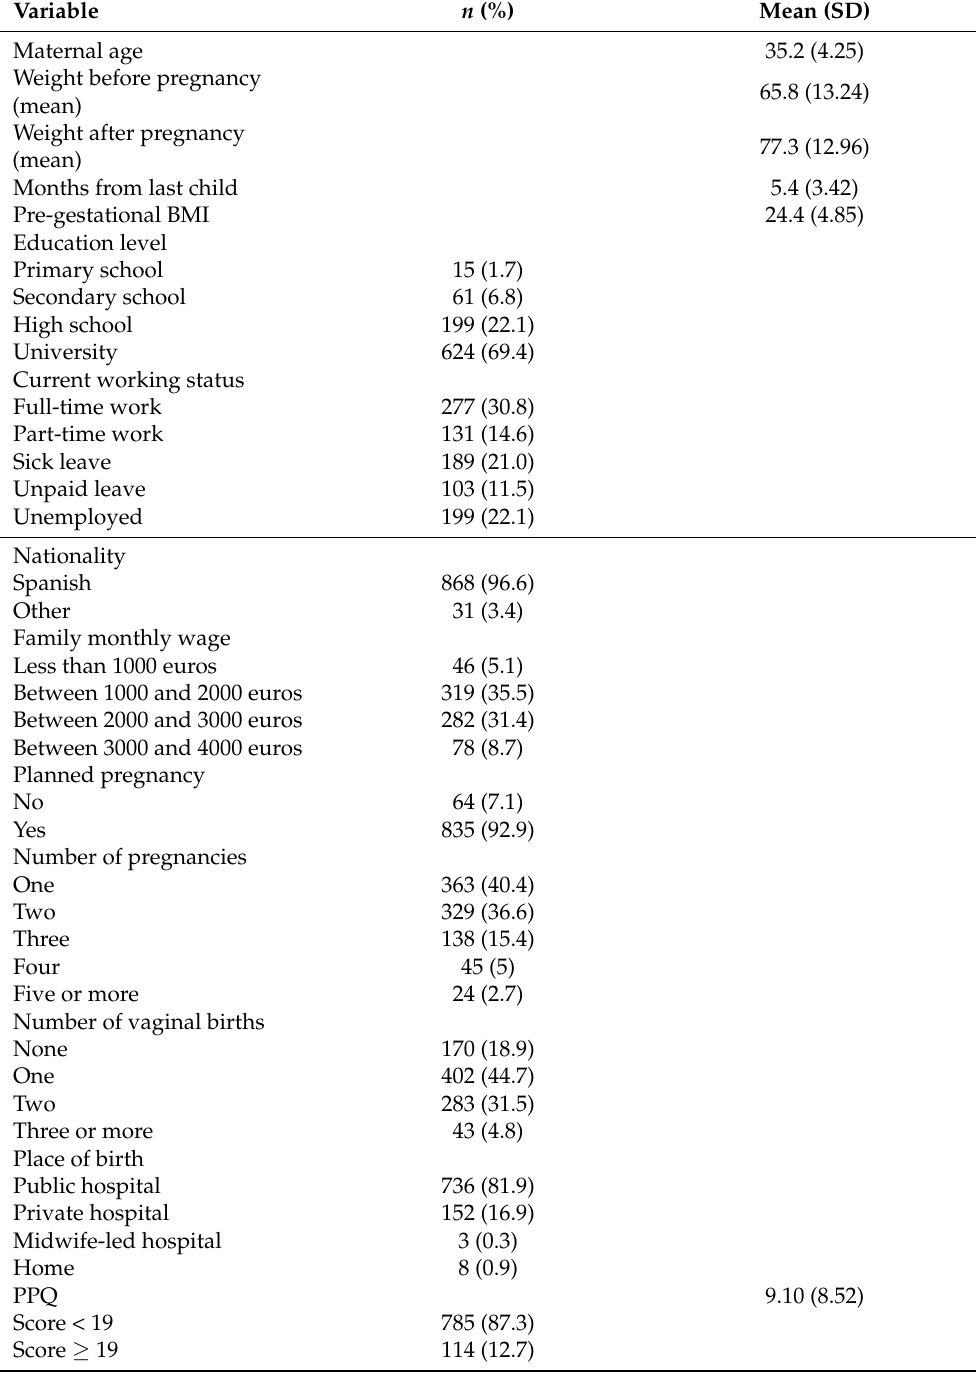
Table 1. Sociodemographic and current pregnancy characteristics of the